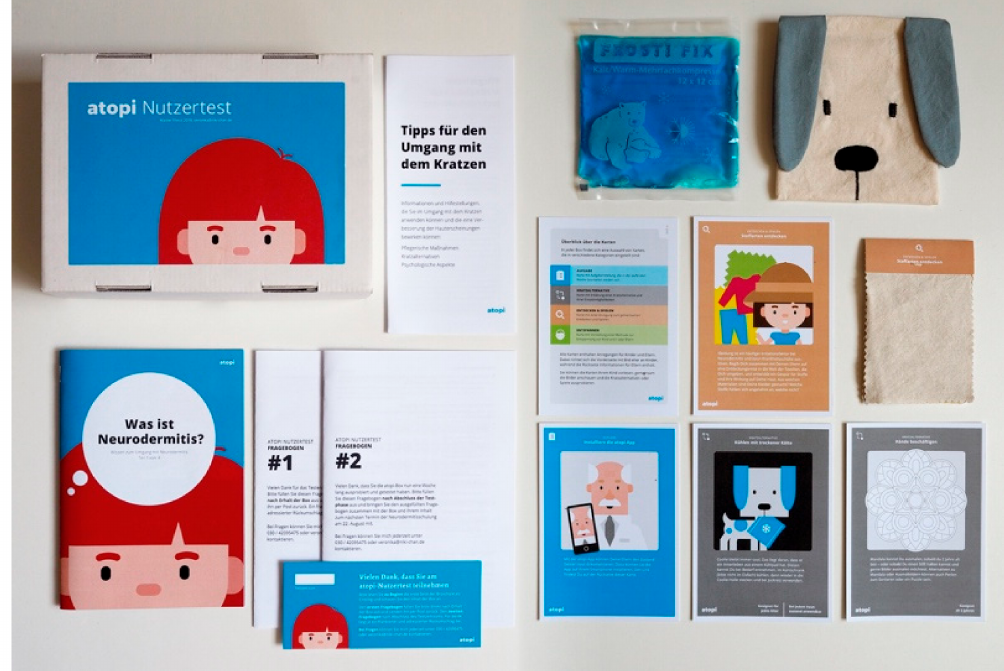
Figure3. Prototype,clockwisefromtopleft: box,folder,coolpadandsleeve(Coolie),cards (withadditional instruction card), fabric swatches, questionnaires with cover card, and brochure. App and video are not